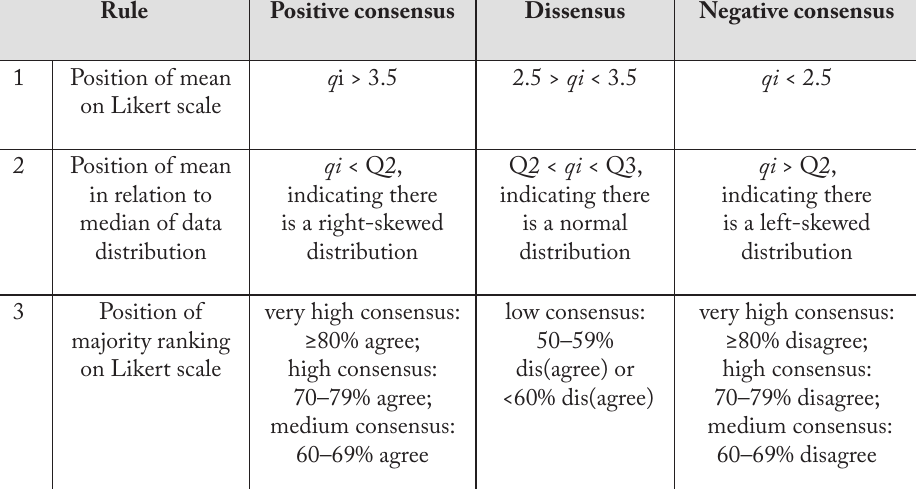
Table 4: Criteria determining consensus over a proposition Rule Positive consensus Dissensus Negative